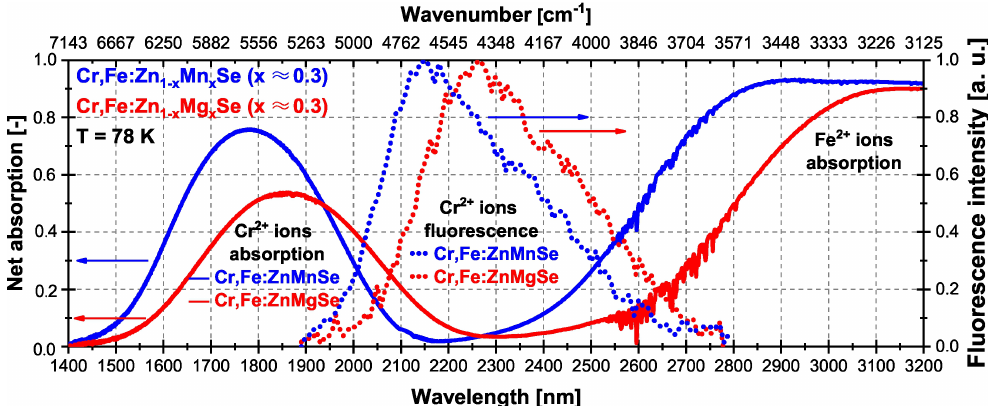
Figure 4. Net absorption spectra of Cr,Fe:Zn 1 − x Mn x Se (x ≈ 0.3) (full blue line) and Cr,Fe:Zn 1 − x Mg x Se (x ≈ 0.3) crystals (full red line) at 78K together with the Cr 2 + ions’ fluorescence spectra (dotted lines of same colors).